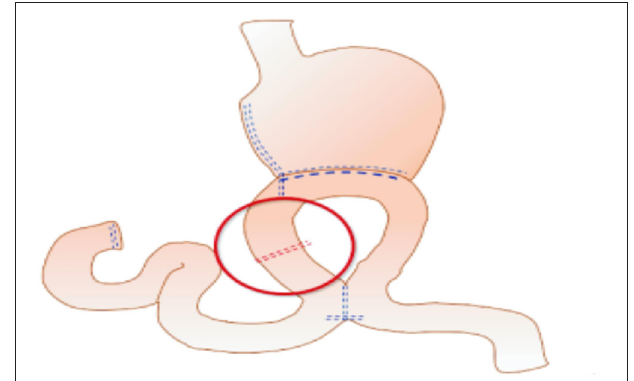
FIGURE 1 | General view of the surgical procedures.